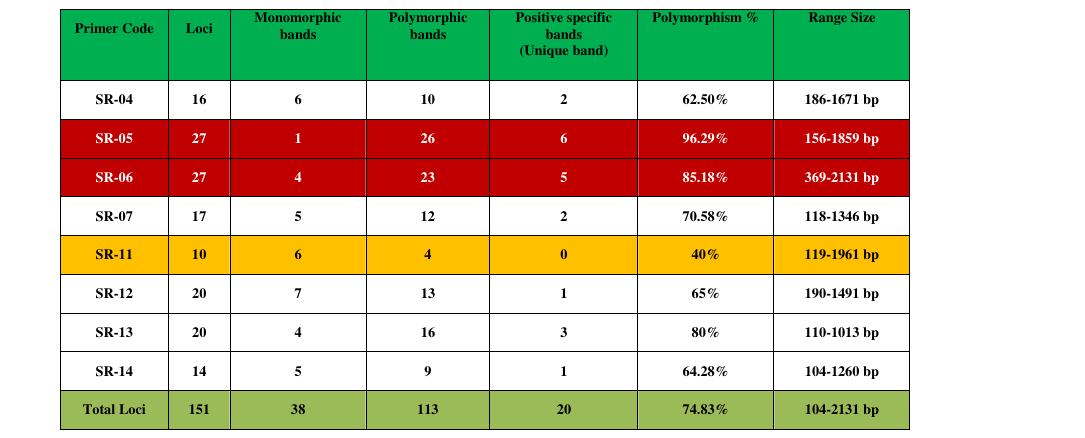
Table 10 The polymorphic loci amplified by the eight ISSR primers for the ten sorghum